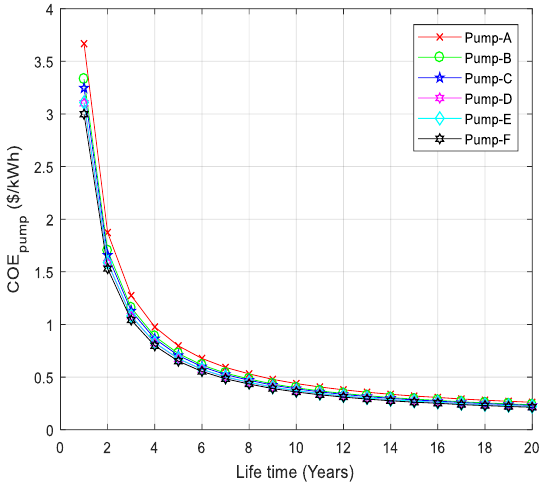
Fig. 5. Energy cost for different